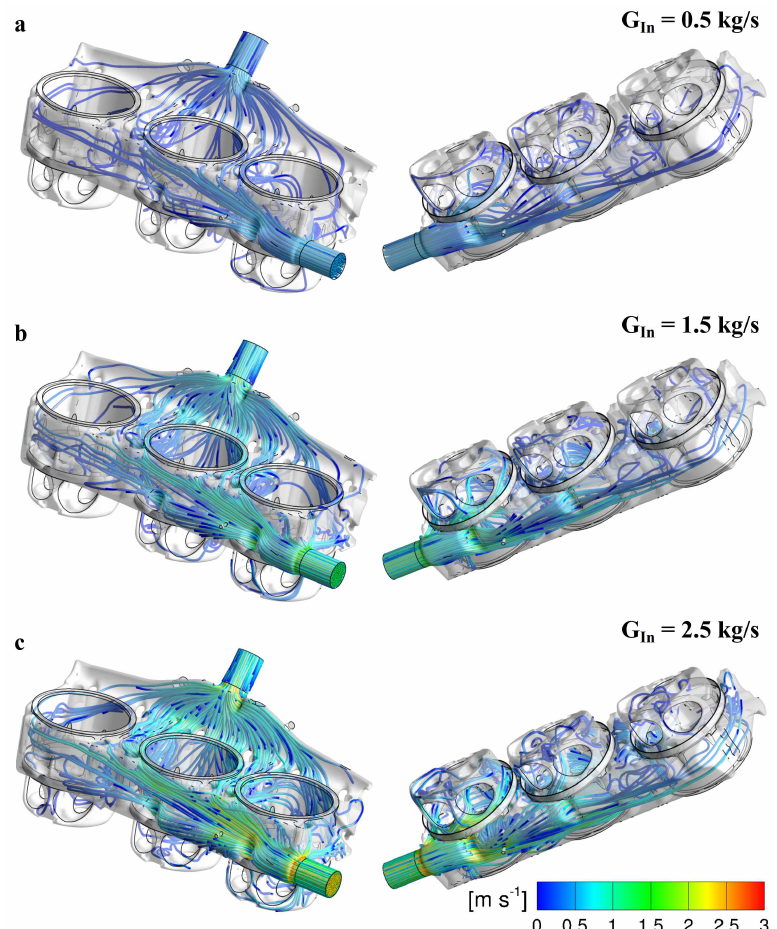
Figure 5. Velocity magnitude colored streamlines for the single-inlet geometry. Velocity magnitude colored streamlines, starting from the inlet section, for G In = 0.5 ( a ), 1.5 ( b ), and 2.5 ( c ) kg/s. Internal (left) and external (right) point of